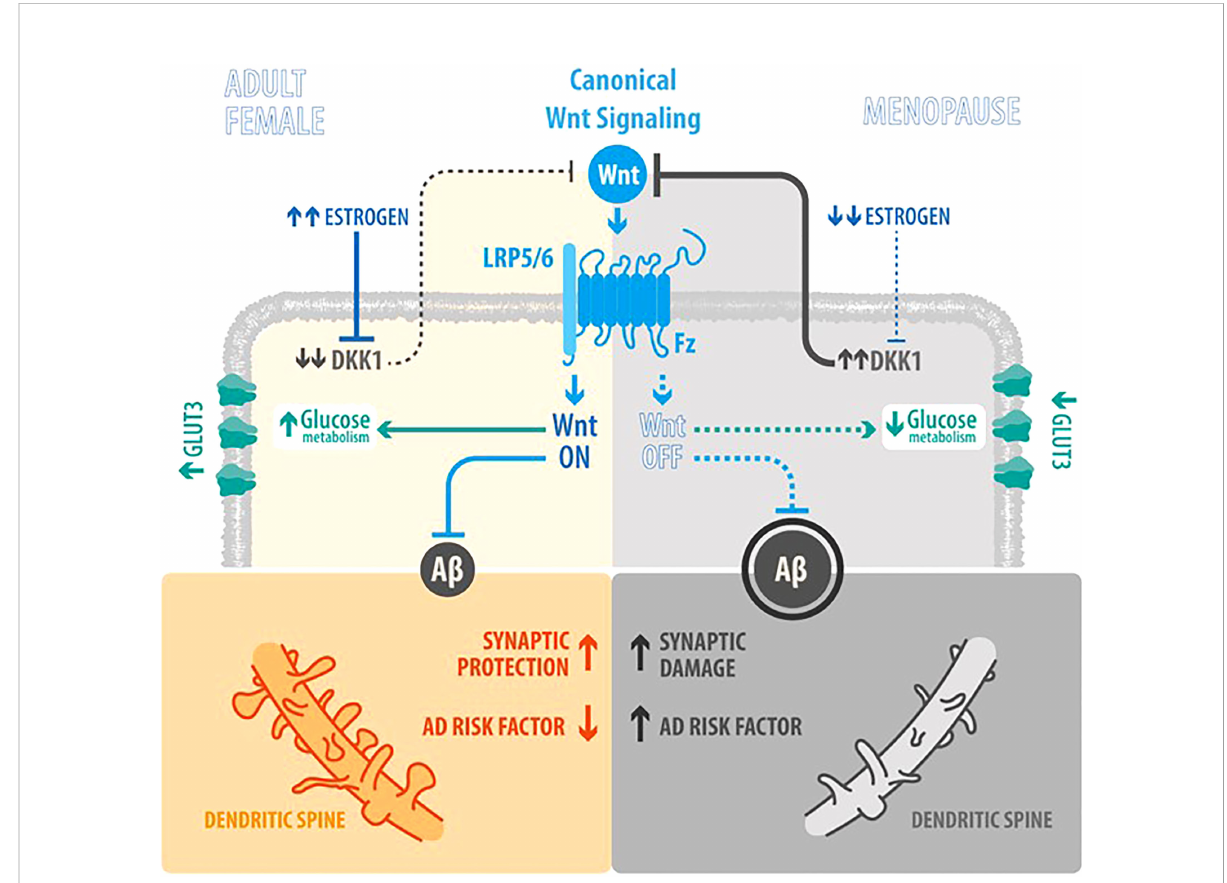
FIGURE 1 How factors are interrelated and their role in AD (Estrogen, Wnt signaling, glucose metabolism and neurodegeneration). Scheme integrating the actions of Wnt signaling, Estrogen levels, A b peptide synthesis and brain glucose uptake in the Adult Female as opposed to the Menopause status: In the Adult Female , estrogen (E 2 ) inhibits the synthesis of Dkk1 (a physiological antagonist of Wnt canonical signaling) (23), thus promoting the activation of Wnt canonical signaling and leading to a decrease of A b peptide synthesis, an increase in synaptic protection and development of dendritic spines; in parallel, also leading to increased brain glucose uptake. In Menopause , the decrease of E 2 induces an increase of Dkk1 and the consequent decrease in Wnt signaling activity, that lead to an increase and aggregation of A b peptide and neuronal damage, as the loss of dendritic spines by the accumulation of plaques; in parallel, the decrease in Wnt signaling activity, decreases brain glucose